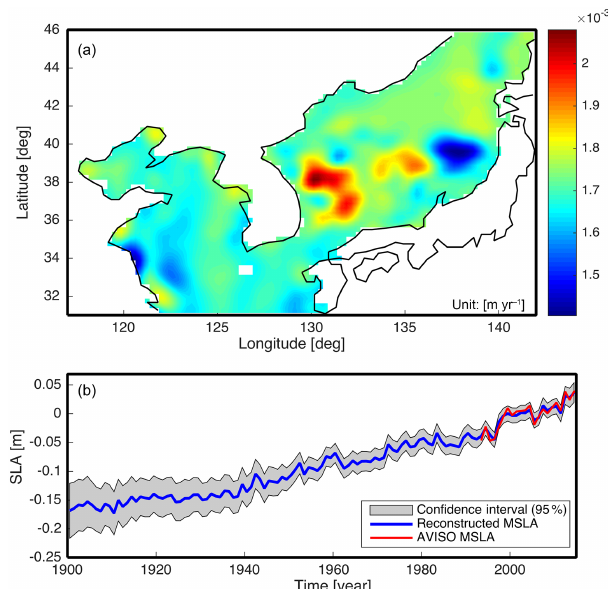
Figure 12. (a) Linear trend map of the best reconstruction of the current study from 1900 to 2014; (b) spatial mean time series of sea level anomalies (MSLAs) of the best reconstruction case (COBESST2 of the northwest Pacific) and 95% confidence inter-